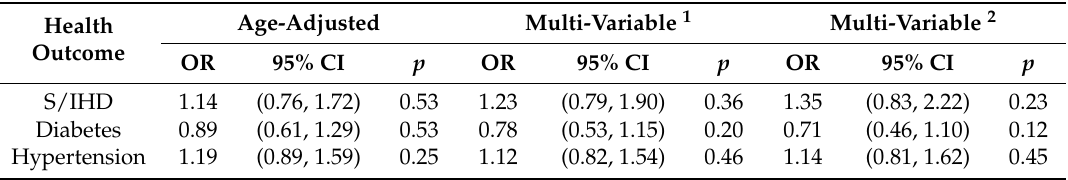
Table 3. Mean TAA-PNC models for association with stroke/ischemic heart disease, diabetes, and hypertension.